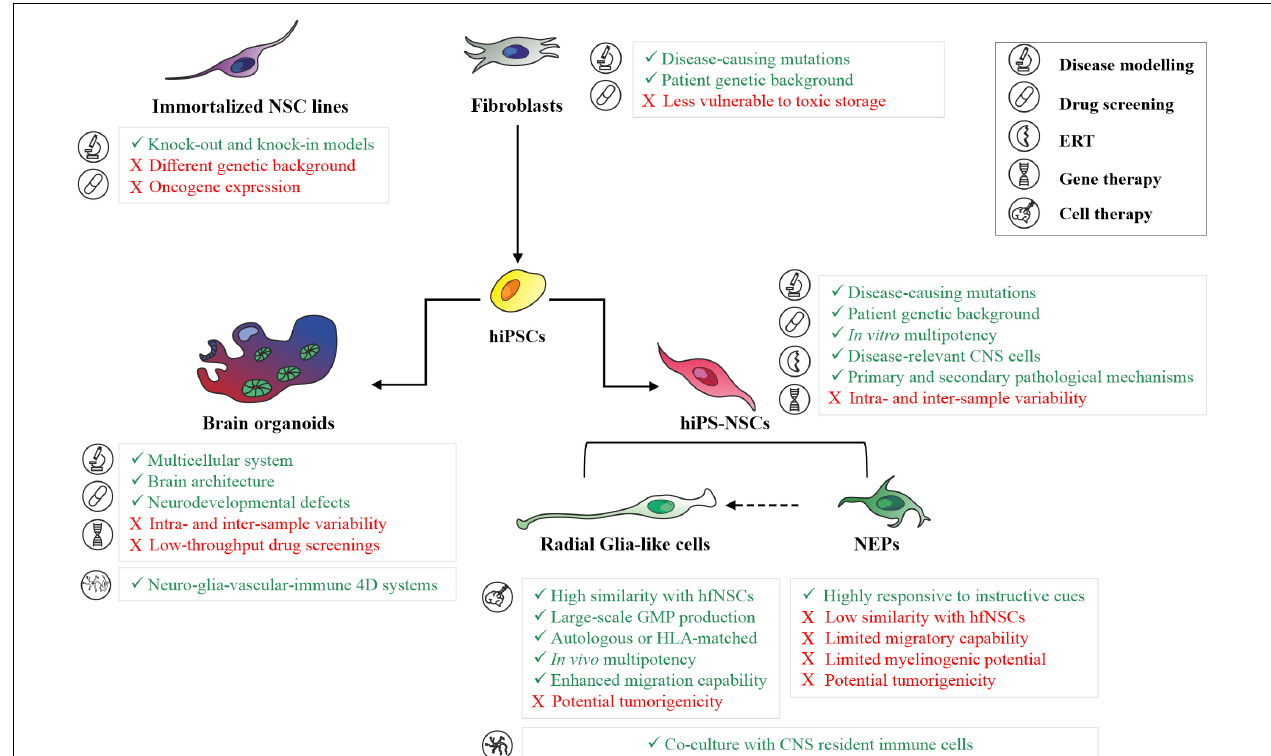
FIGURE 1 | Human 2D and 3D in vitro models for basic and translation research in neurodegenerative LSDs. Summary of main advantages (green text) and limitations (red text) in the application of patient skin fibroblasts, immortalized neuronal cell lines, hiPS-NSC cell populations (neuroepithelial cells and radial glial-like cells), and brain organoids for disease modeling studies, development of novel therapeutics (drug screening, enzyme replacement therapy, gene therapy), and cell therapy in neurodegenerative LSDs. ERT, Enzyme Replacement Therapy; NEPs, Neuroepithelial